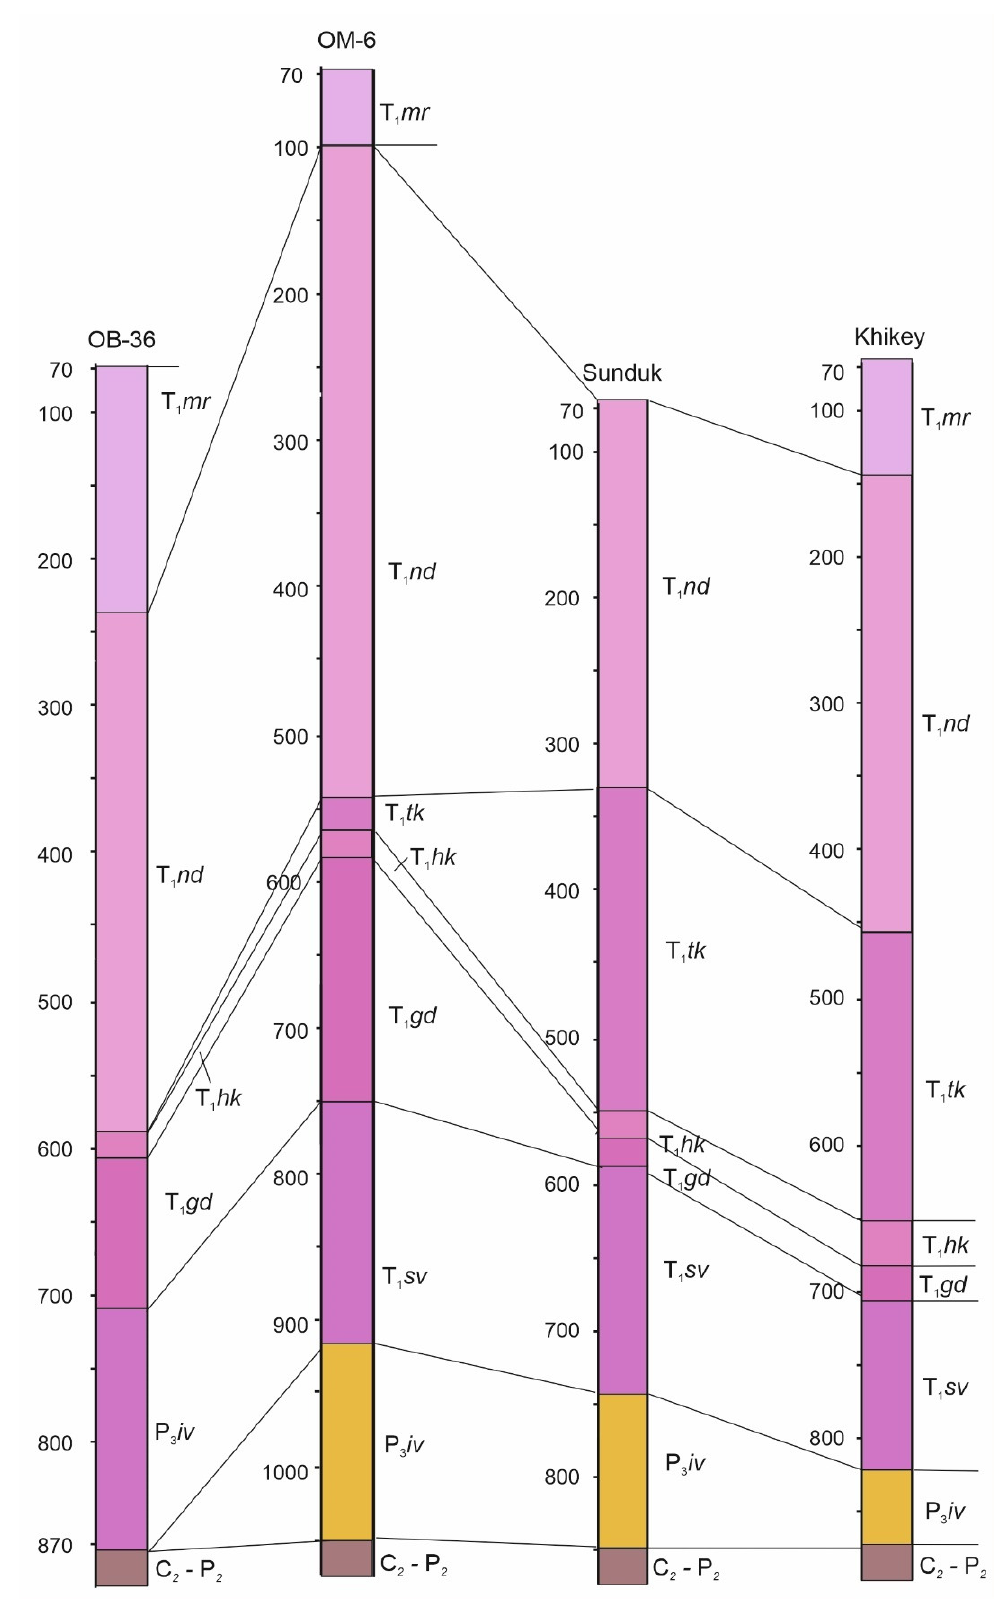
Figure 7. Correlation of volcanic sequences within the Norilsk